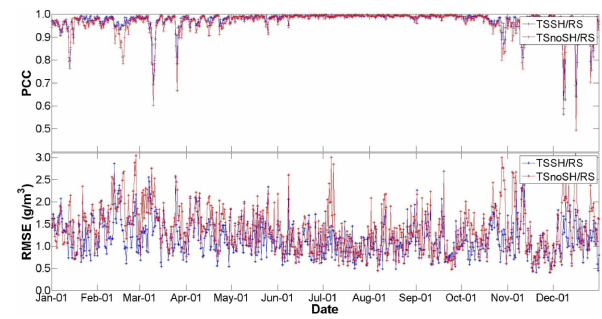
Figure 4. Histogram of the differences between different tomo- graphic solution and radiosonde data. Mean value of the differ- ences is 0.1294gm − 3 for TSSH and 0.1659gm − 3 for TSnoSH, with standard deviation 1.2797gm − 3 for TSSH and 1.4295gm − 3 for TSnoSH.